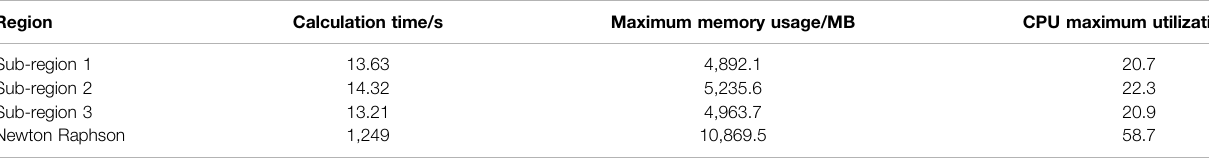
TABLE 2 | Ef fi ciencies of the 100,000-sample generation process on the IEEE39 power system.